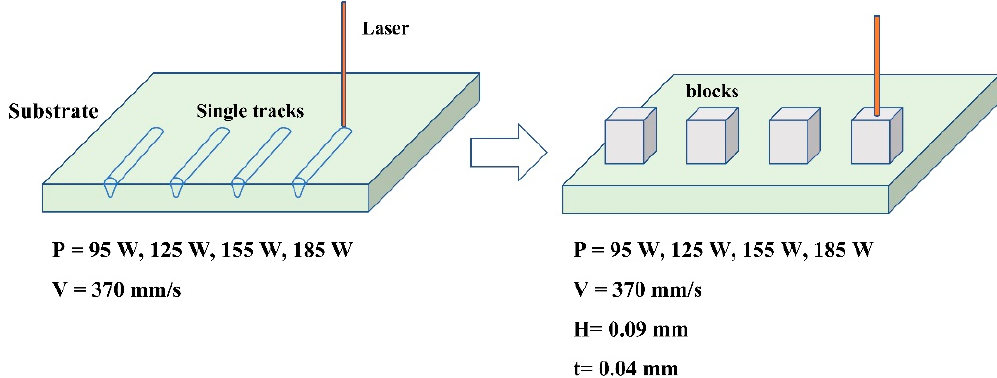
Figure 2. Schematic diagram of the WC-17Co samples prepared by L-PBF.